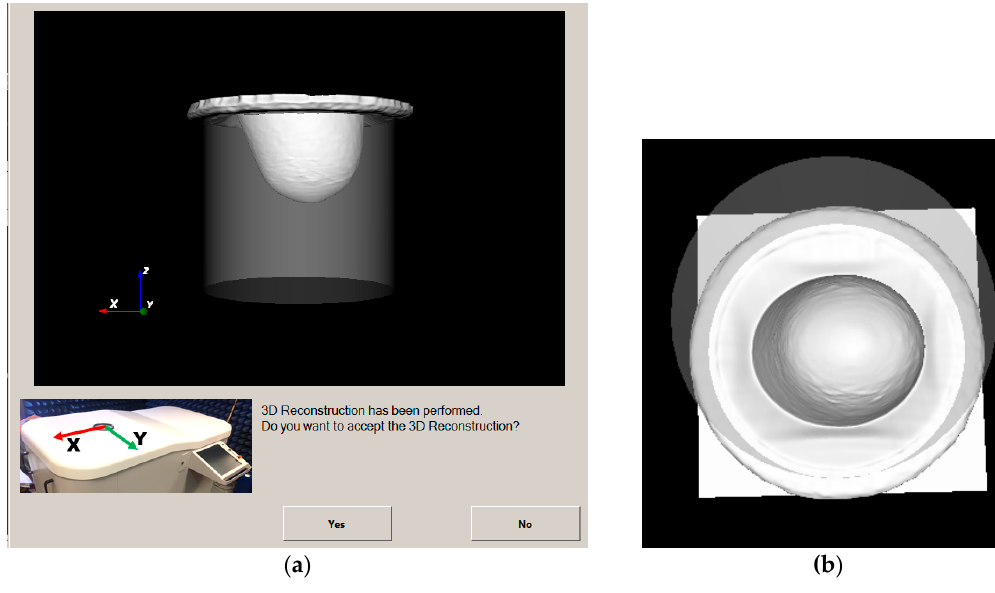
Figure 10. Reconstructed outer surface of the breast phantom #1 ( a ) Screen capture from the Wavelia Optical Breast Contour Detection subsystem, as provided to the user, ( b ) Zoomed bottom view of the reconstructed outer surface of the breast.